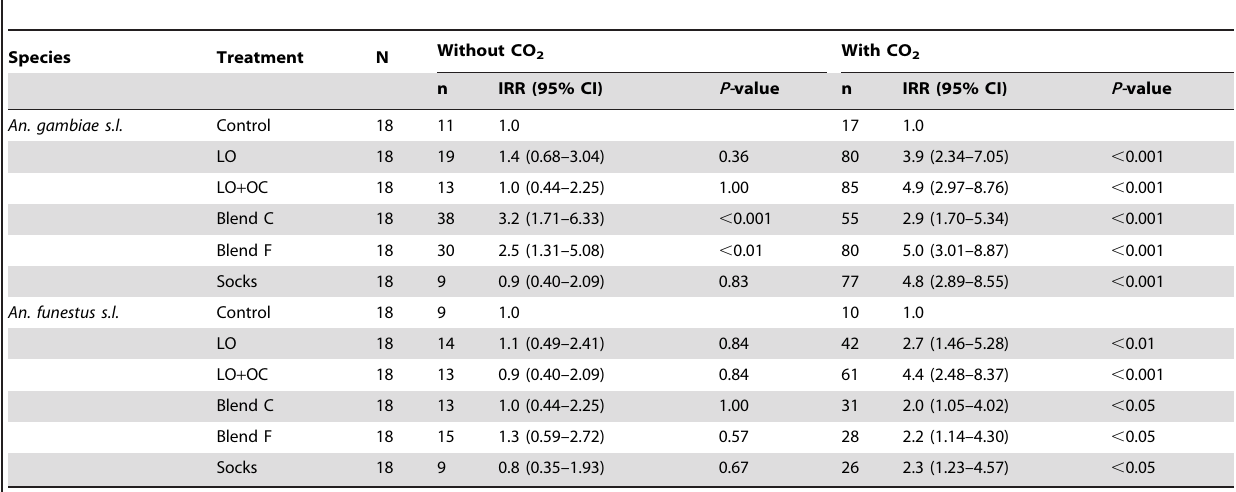
Table 3. Total anopheline trap captures with plant and animal odor compounds and worn socks in the presence or absence of carbon dioxide using CDC